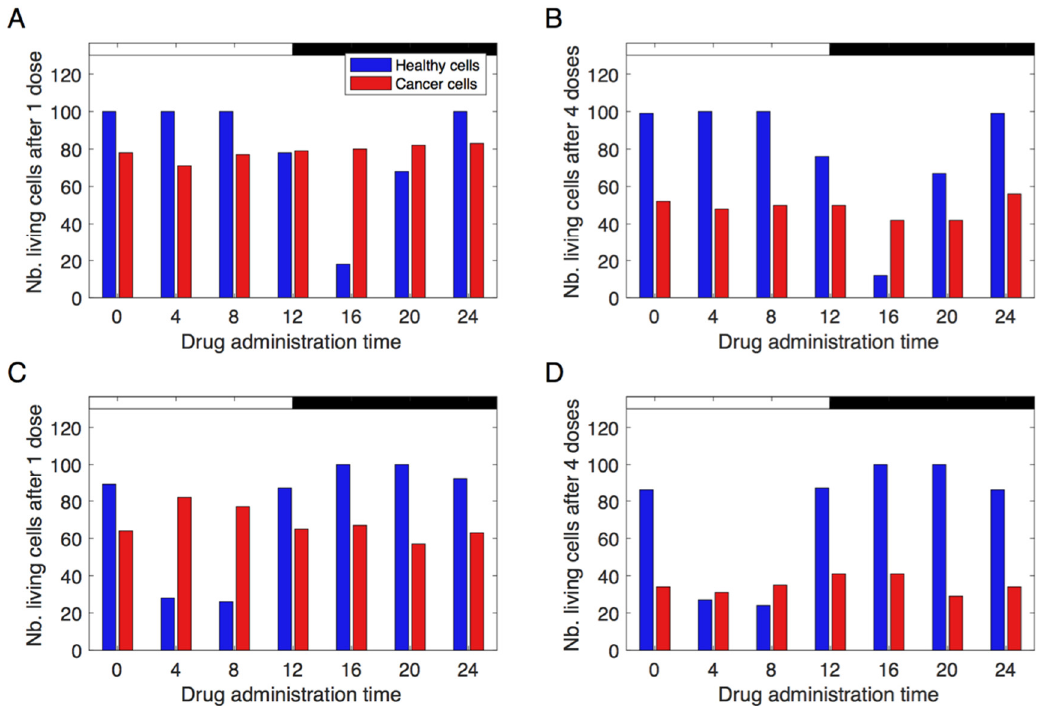
Figure 5. Effect of the schedule of the treatment. The different histograms give the number of living entrained/healthy (blue) vs. non-entrained/cancer cells (red) remaining after the application of an anti- Mb drug (panels ( A , B )) or anti- Me drug (panels ( C , D )), when a single dose (panels ( A , C )) or 4 doses at an interval of 5 days (panels ( B , D )) is administered. As in Figure 4, the initial number of cells is 100, the drug targets cells with a level of Mb/Me larger than 0.95, and the duration of the application of the drug is 0.5 h. ZT 0 represents the beginning of the L phase (i.e., start of expression of Wee1).